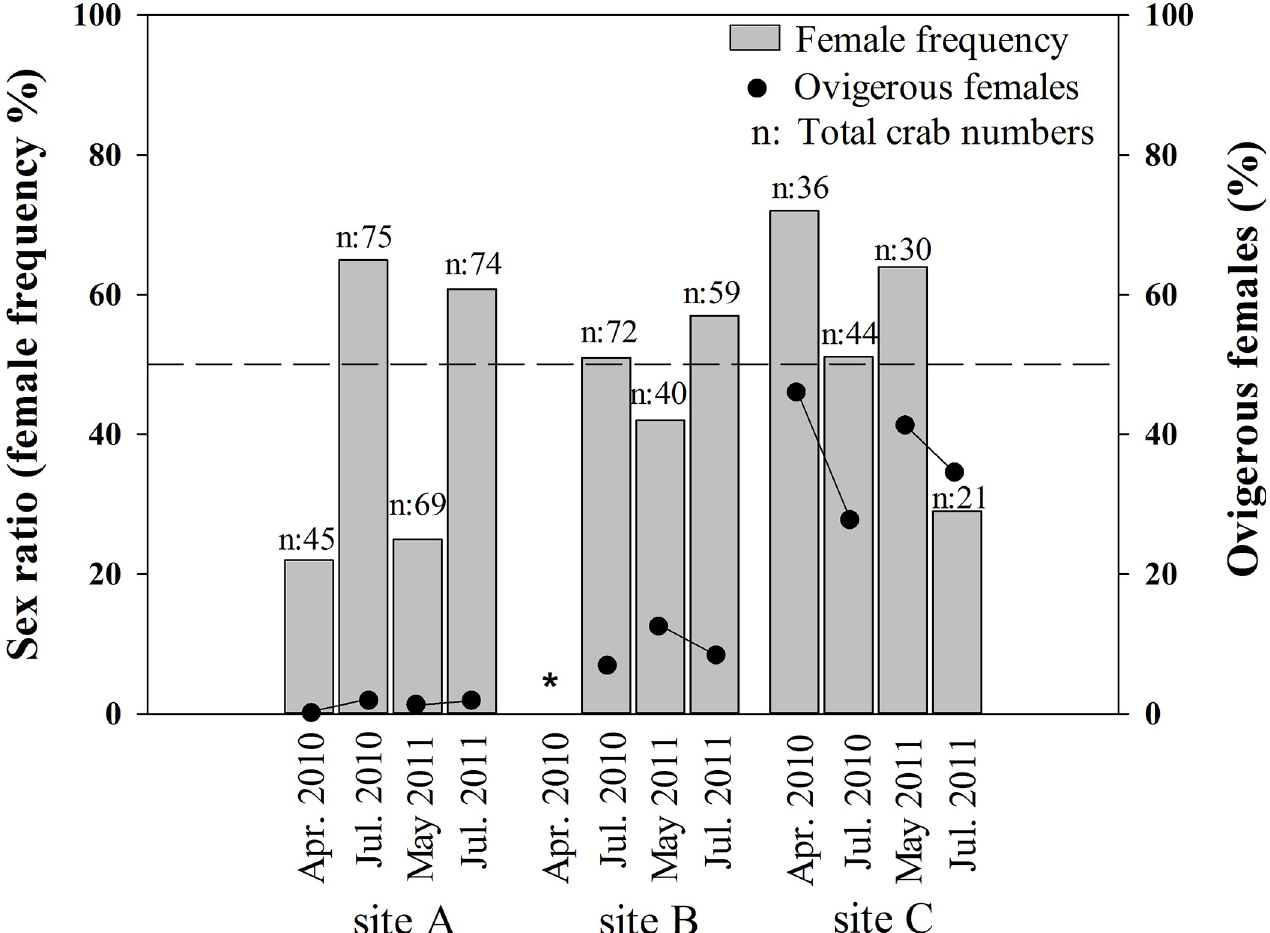
Fig 2. Ovigerous ratios of X . testudinatus females collected from three sites. Distribution of isotopic signatures of carbon and nitrogen in organisms collected from the Kueishan hydrothermal field. The geometric marks indicate (mean ± SD) in X . testudinatus samples. Open: male; solid: female; triangle: samples from site ‘A’; square: samples from site ‘B’; circle: samples from site ‘C’.